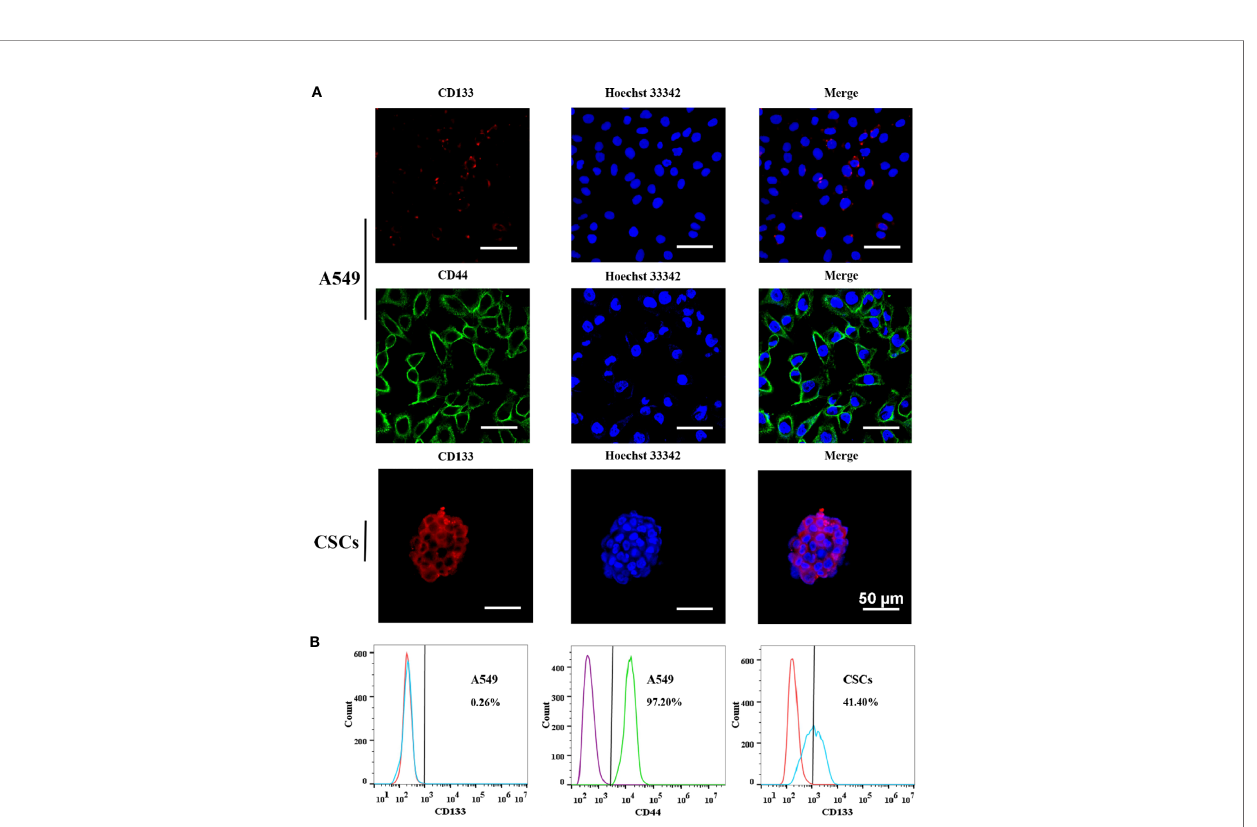
FIGURE 7 | The expressions of stem cell surface markers in A549 CSCs. (A) Immuno fl uorescence staining of A549 cells and CSCs. A549 cells were stained for CD44 and CD133. CSCs were stained for CD133. Pictures were taken using a Nikon microscope. The bar represents a distance of 50 m m. (B) Flow cytometry analysis of CD44 expression in A549 cells and CD133 in A549 cells and CSCs. Red histograms presented cells stained with PE Rat IgG1, k Isotype Control. Blue histograms presented cells stained with PE Anti-Human CD133. Purple histograms presented cells stained with FITC Rat IgG1, k Isotype Control. Green histograms presented cells stained with FITC Anti-Human